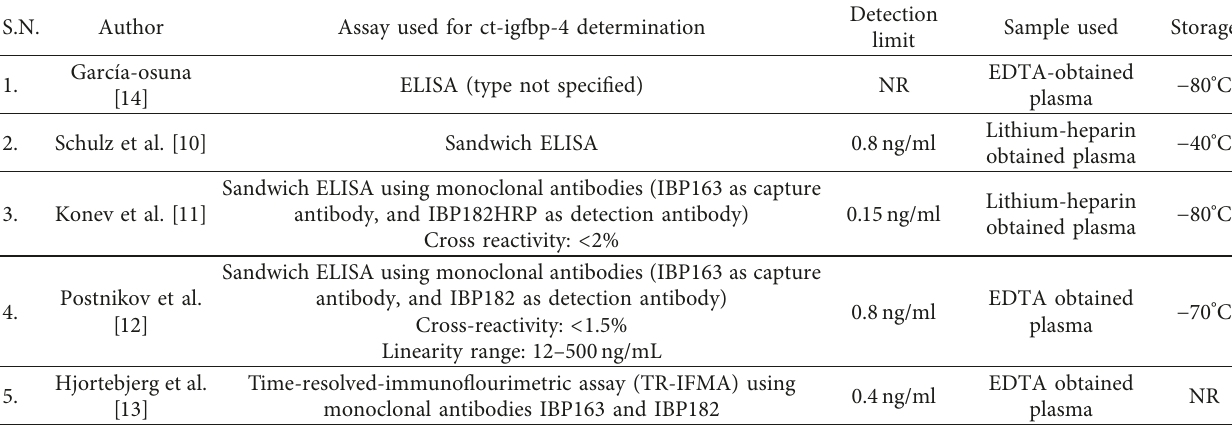
Table 3: Description of the assay used in CT-IGFBP-4 measurements in the included studies.